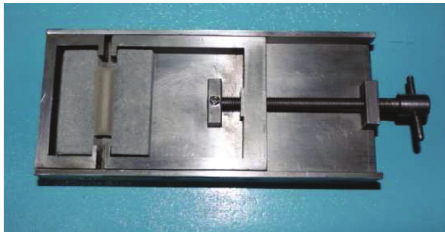
Figure 3: Grip for constant elongation bonding test.